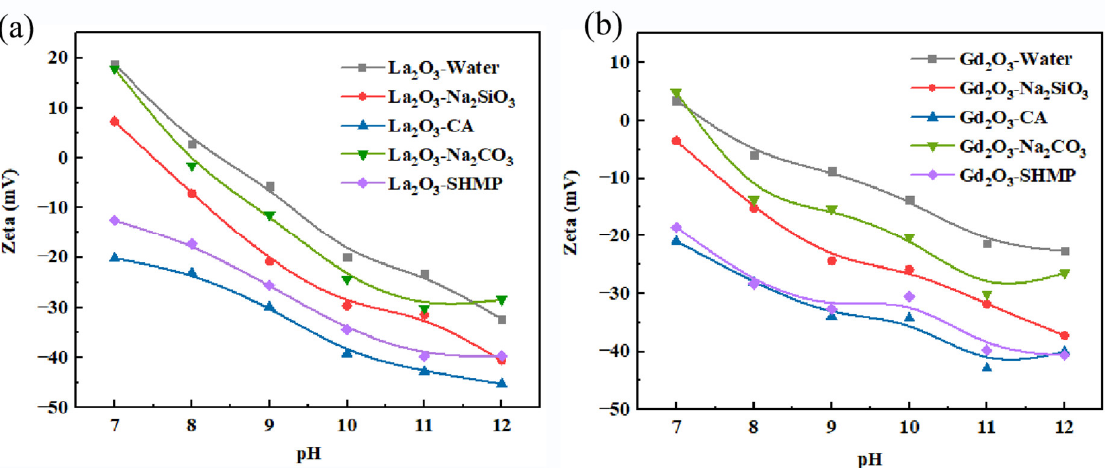
Figure 7. Zeta potential curves of ( a ) La 2 O 3 and ( b ) Gd 2 O 3 in water and with the addition of four different dispersants. (Concentration: Na 2 SiO 3 0.03 wt%, CA 0.01 wt.%, Na 2 CO 3 0.03 wt%, SHMP 0.16 wt%)